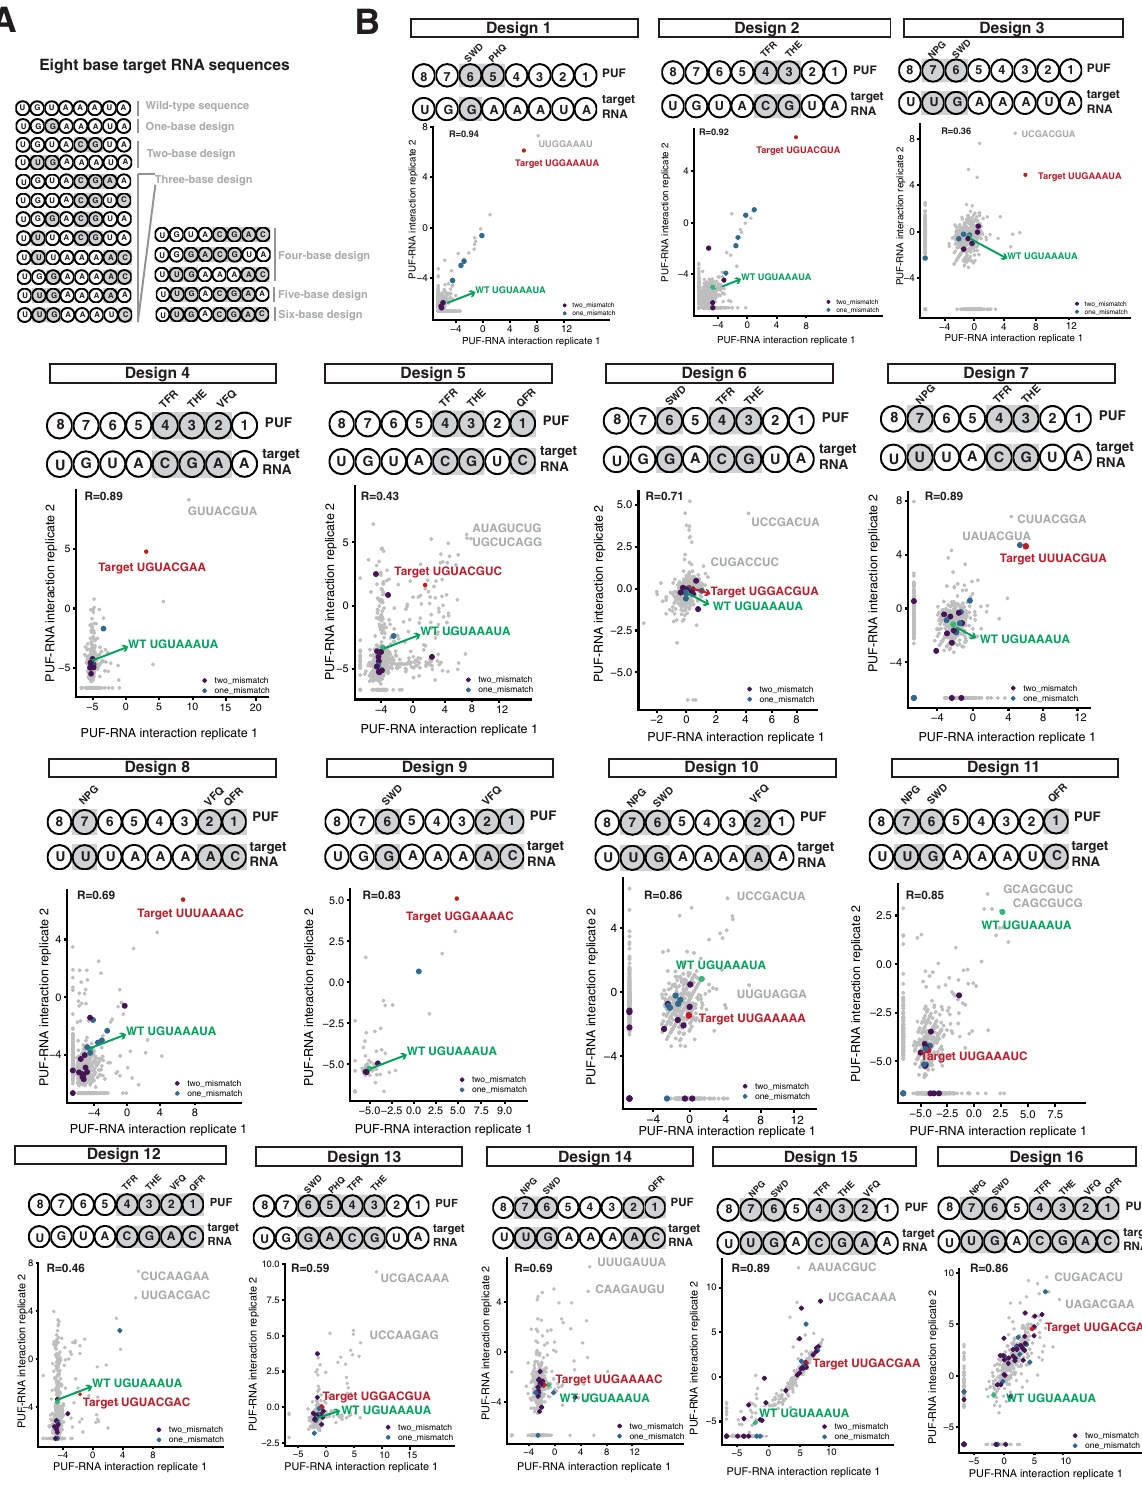
Fig. 6 RNA sequences that bound to designed PUF domains. A Target RNA designs, showing the substituted bases and designed TRM combinations in gray. B Sixteen three-hybrid selections were carried out in duplicate and interaction scores for each RNA in both replicates were plotted. The upper panel of each experiment indicates the locations and substitutions made in the PUF domain and target RNA. The lower panel is a correlation plot between the two replicates, with each dot an RNA sequence. Green indicates the RNA sequence recognized by the wild-type PUF domain; red indicates the target RNA sequence; gray indicates the top two enriched sequences based on the averaged interaction score from the two replicates, if these interaction scores are higher than the target RNA sequence. The X and Y axes indicate two replicates of the experiment. The sequence UCCGACUA was highly enriched in some of the replicates and was removed, and then the interaction scores of the remaining RNA sequences were plotted, which resulted in the different scales of the X and Y